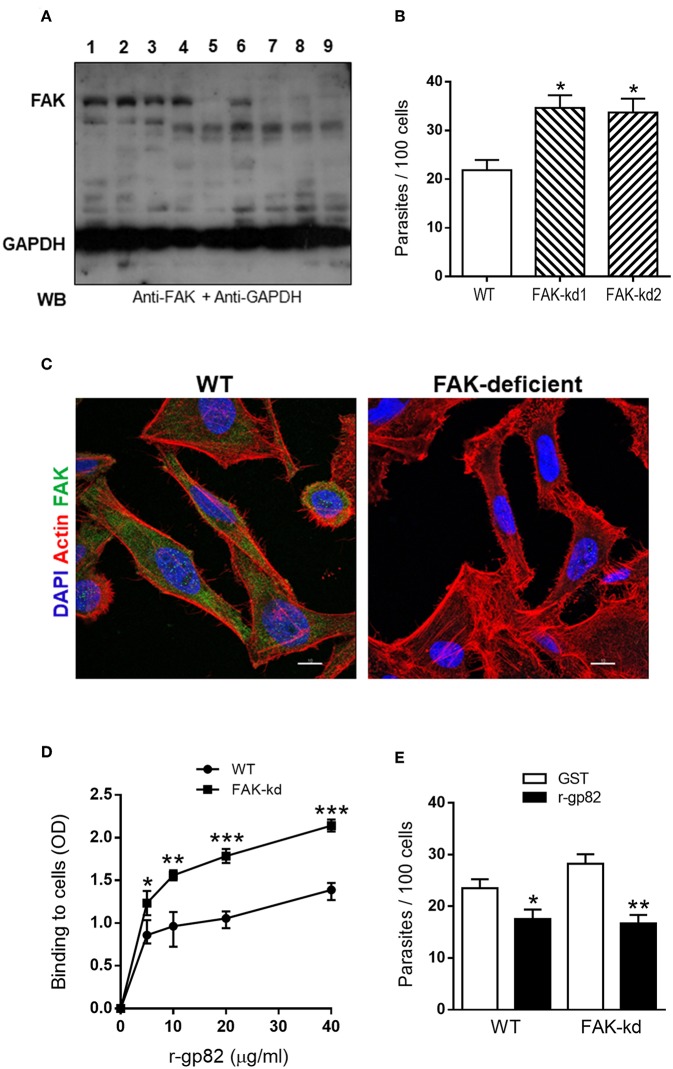
FAK knockdown increases host cell susceptibility to T. cruzi MT invasion and gp82 binding capacity. (A) HeLa cells were subjected to lentiviral transduction for FAK knockdown (kd) and then analyzed by western blotting (WB) using the indicated antibodies. Shown are the wild type (WT) cells (lane 1), cells transduced with lentivirus containing unrelated sequence (lanes 2 and 3), cells targeted with FAK sequence 1 (lanes 4, 5, 6) or with FAK sequence 2 (lanes, 7, 8, 9). Note the FAK depletion in four cell lines (lanes 5, 7, 8, 9). (B) WT cells and two FAK-depleted cell lines (FAK-kd1 and FAK-kd2) were incubated with MT for 1 h and then processed for intracellular parasite counting. Values are the means ± SD of three independent assays performed in duplicate. MT invasion was significantly increased in FAK-deficient cells (*P < 0.005). (C) WT and FAK-deficient cells were processed for immunofluorescence analysis using anti-FAK antibody, Alexa Fluor 488-conjugated anti-mouse IgG (green), TRITC-phalloidin (red) for actin detection and DAPI (blue) for DNA, under 63x objective. Scale bar = 10 μm. (D) WT and FAK-deficient cells, grown in microtiter plates, were fixed and incubated sequentially with r-gp82, anti-gp82 antiserum, and anti-mouse IgG conjugated to peroxidase. The binding of r-gp82, revealed with o-phenylenediamine and expressed as optical density value, was significantly higher in FAK-deficient cells than in WT cells (*P < 0.05, **P < 0.01, ***P < 0.001). A representative result of three independent assays performed in triplicate is shown. (E) WT and FAK-deficient cells were incubated with MT in the presence of r-gp82 or GST. Values are the means ± SD of three independent assays performed in duplicate. MT invasion was significantly decreased in the presence of r-gp82 (*P < 0.05, **P < 0.005).